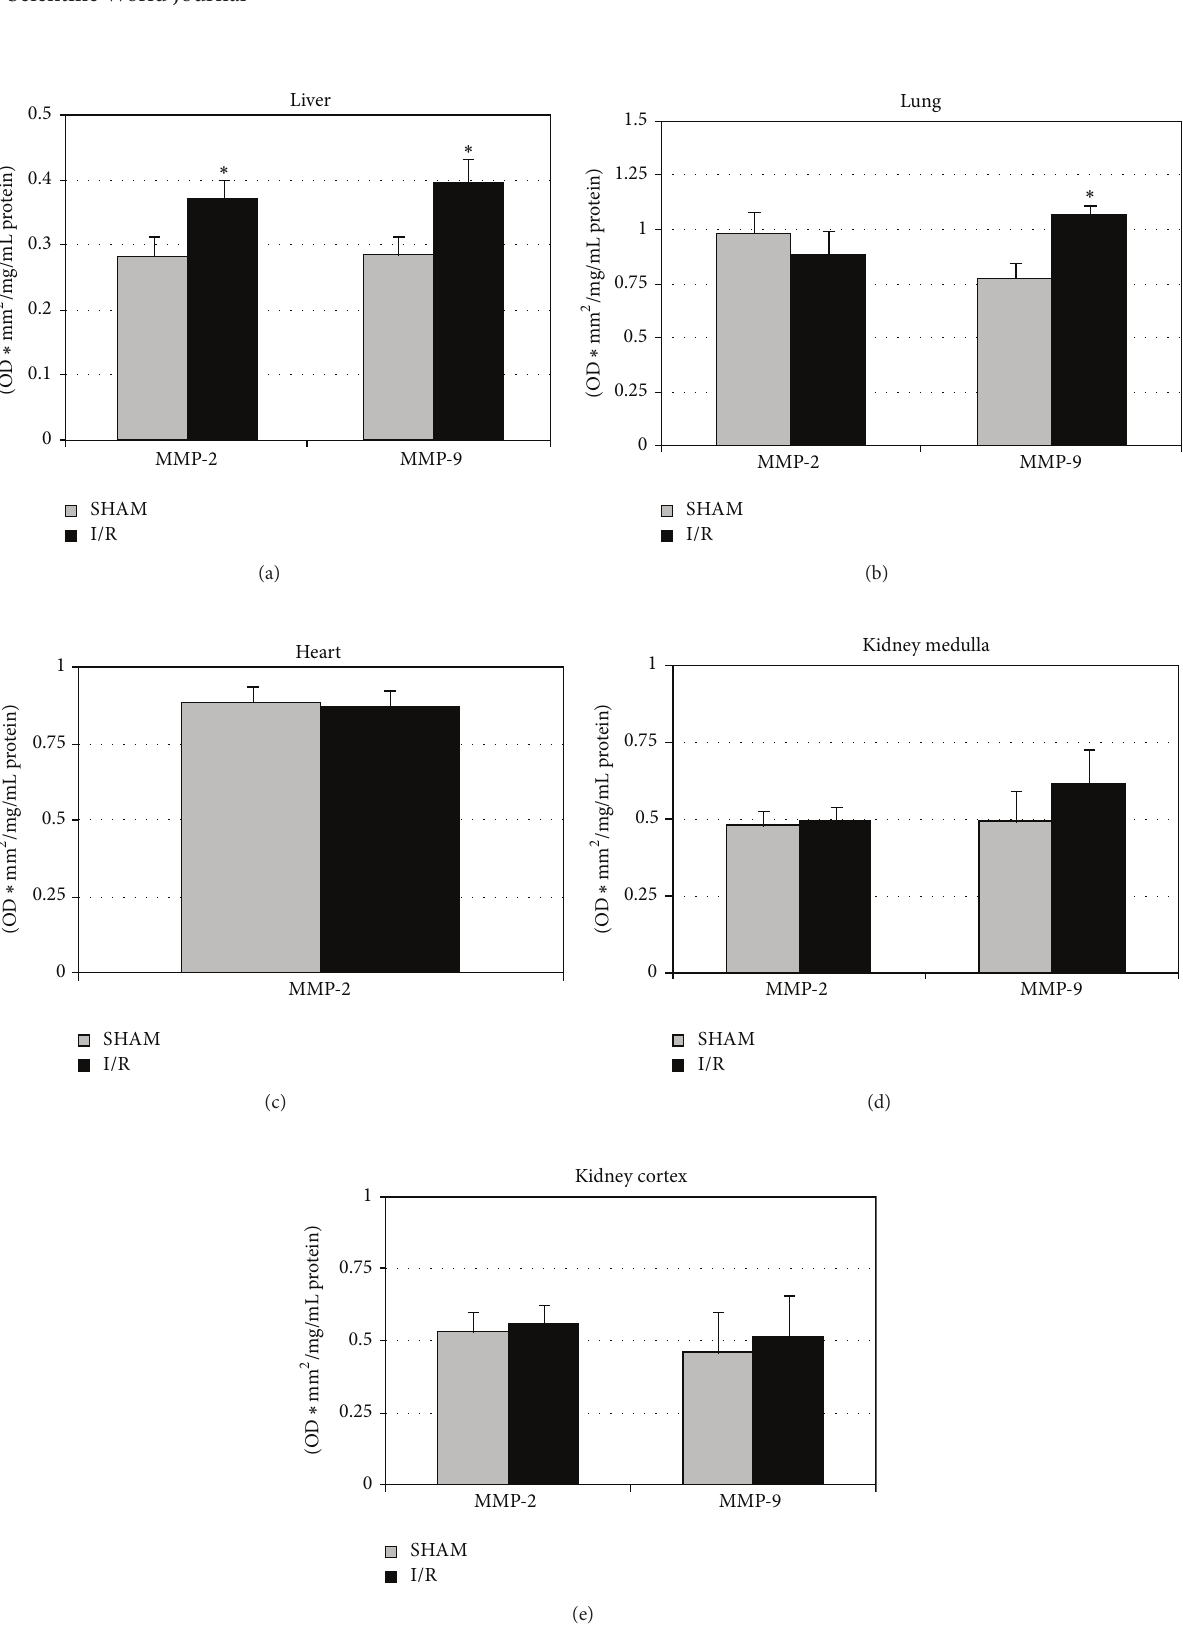
Figure 2: Bar graphs of MMP-2 and MMP-9 activity in ischemic liver lobe (a), lung (b), heart (c), kidney cortex (d), and medulla (e). Sham- operated group (control, 𝑛 = 15 ) has been compared with I/R group ( 𝑛 = 17 ): ∗ 𝑃 < 0.05 . Data are shown as mean values ±